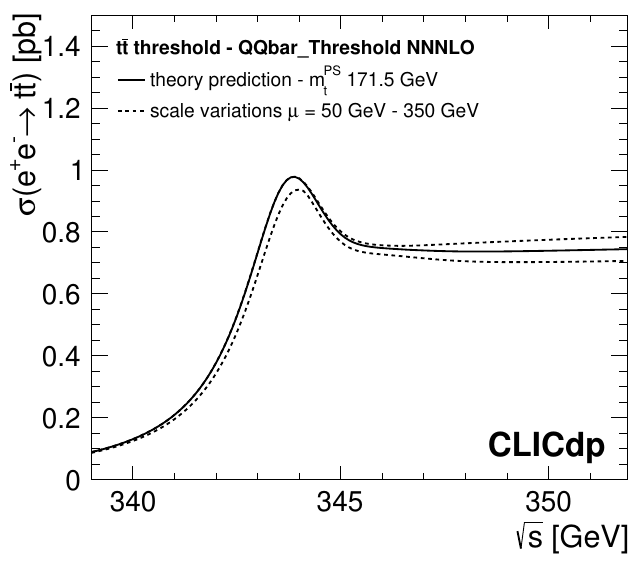
Figure 5. Cross section of top-quark pair production in the threshold region, showing the NNNLO QCD theory cross section obtained with QQbar threshold [22] and the associated renormalisation scale